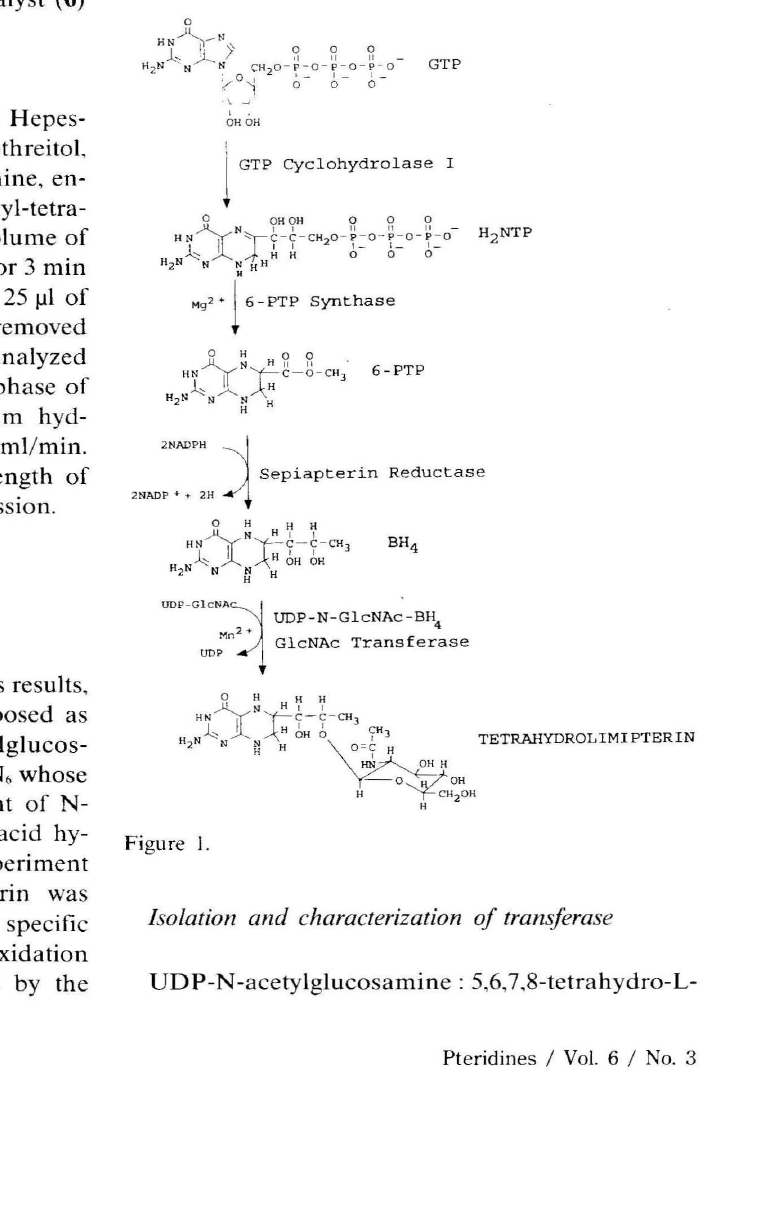
Isolation and characterization of transferase UDP-N-acetylglucosamine : 5,6,7,8-tetrahydro-L-